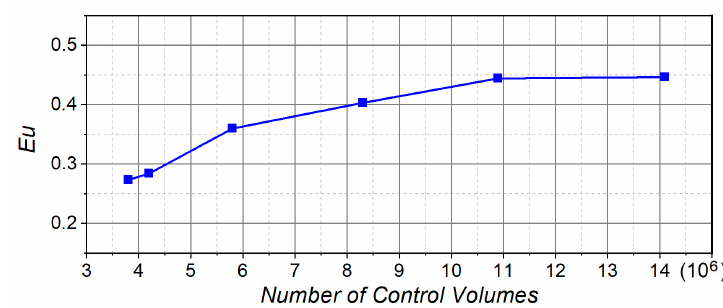
Figure 6. Eu dependence on the number of control volumes.